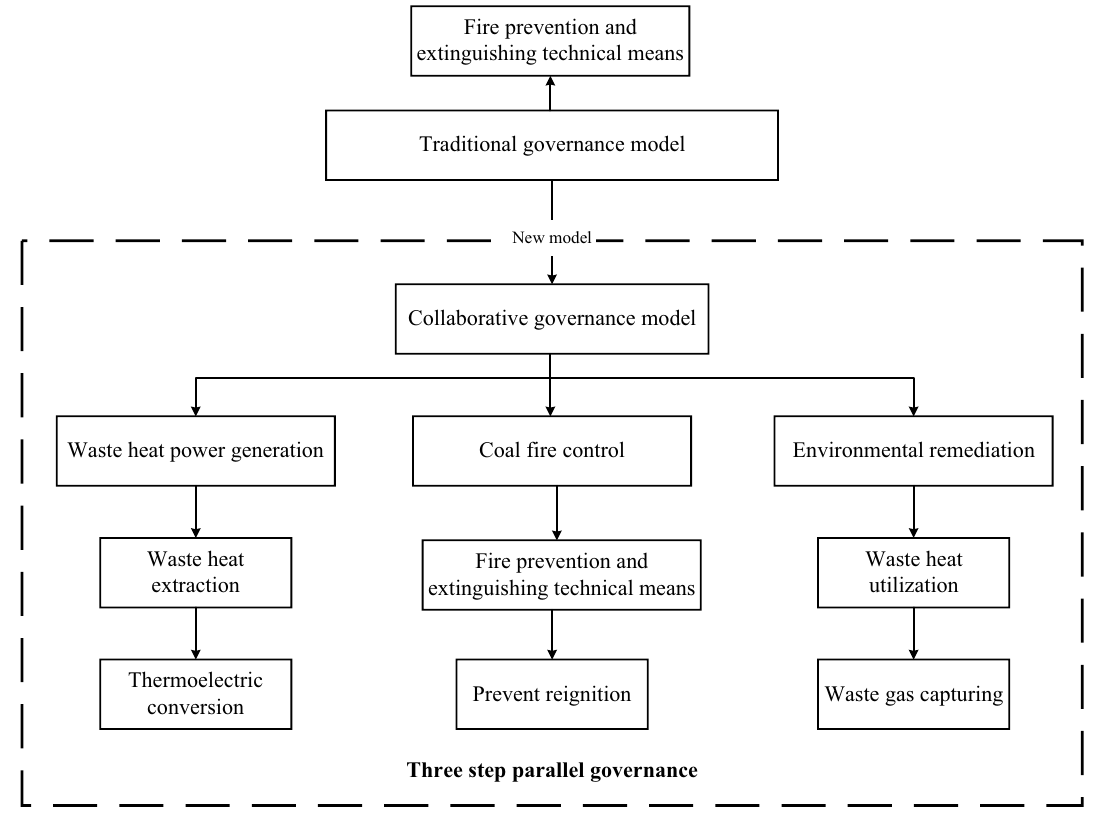
Fig. 11 New model of coal fire